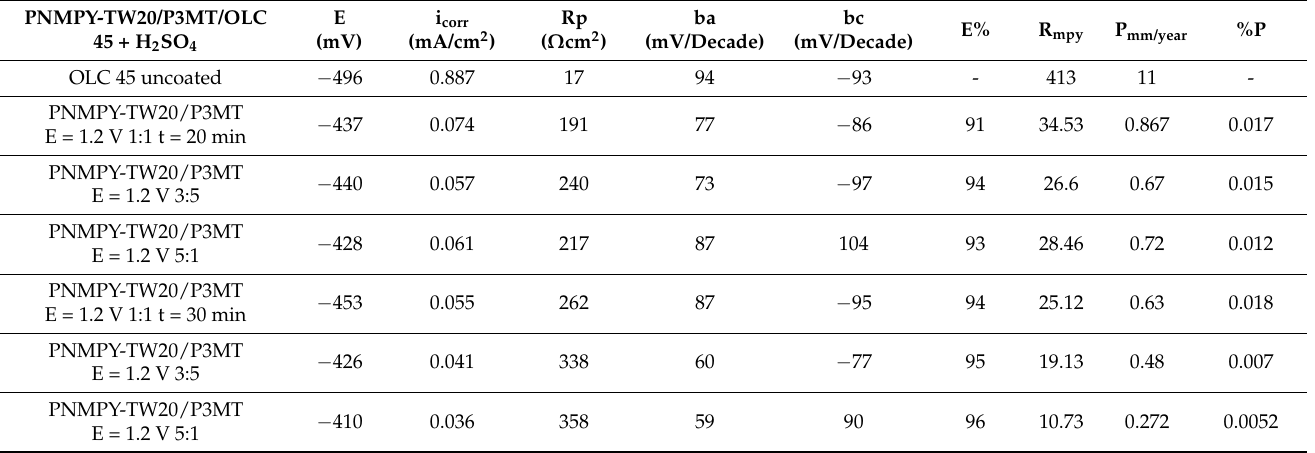
Table 3. Kinetic corrosion parameters of coated and uncoated OLC 45 sample in 0.5 M H 2 SO 4 solution at 25 ◦